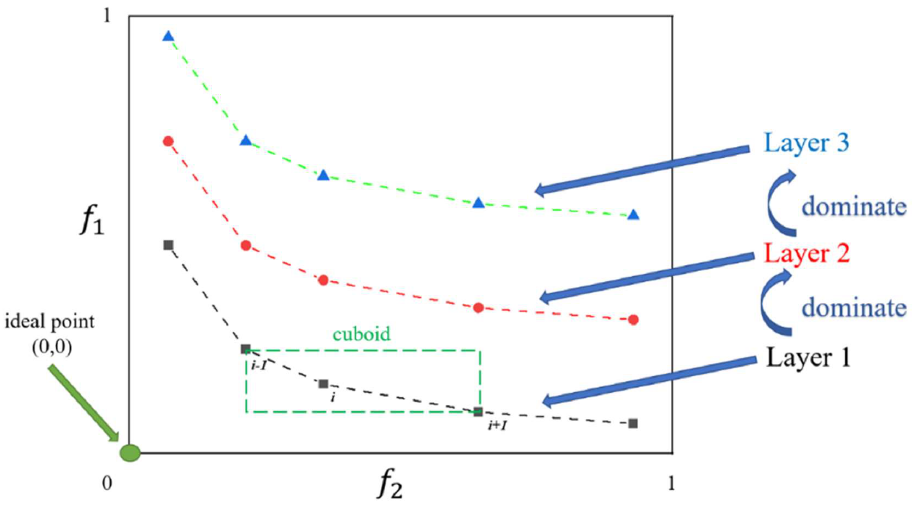
Figure 1. Crowding-distance calculation.